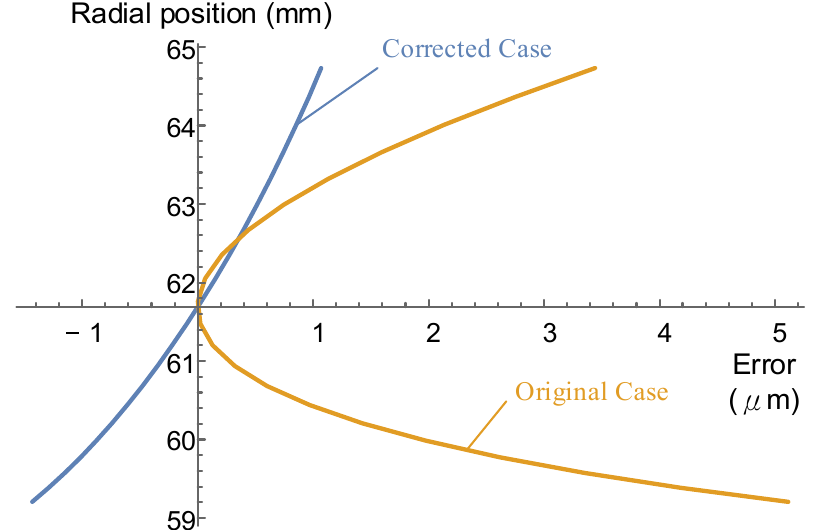
ξ= − . Figure 16. Comparison of the cutter edge profile error for ξ = − 2.5.